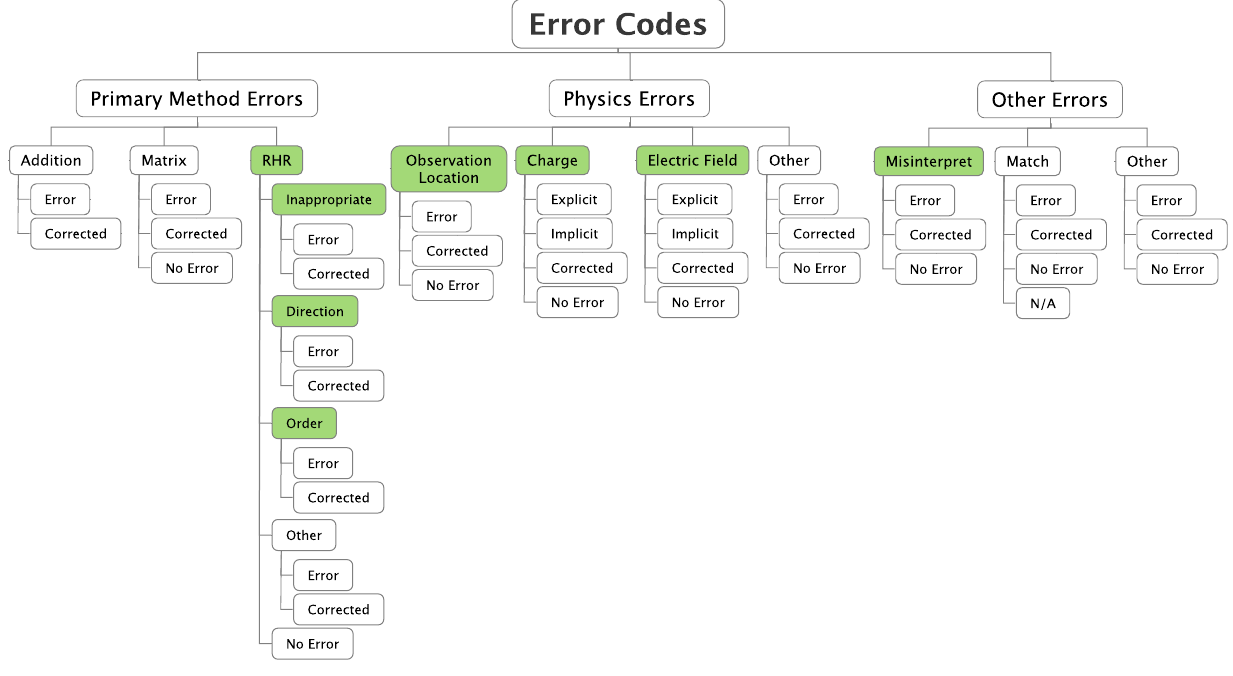
FIG. 9. Graphical depiction of error codes and subcodes. Codes in green are discussed in the text and described in Table